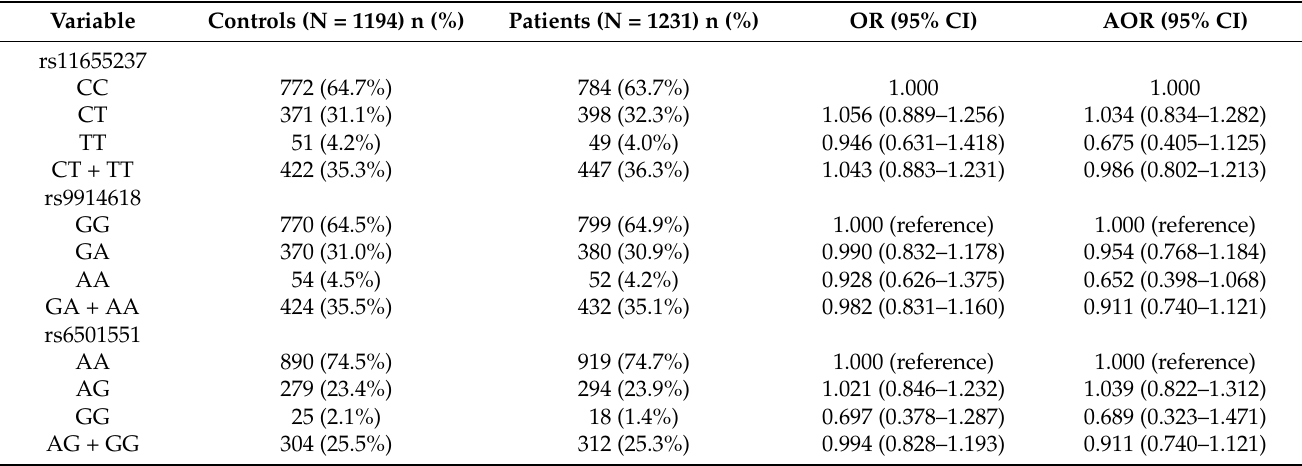
Table 2. Odds ratio (OR) and 95% confidence interval (CI) of OSCC associated with LINC00673 genotypic